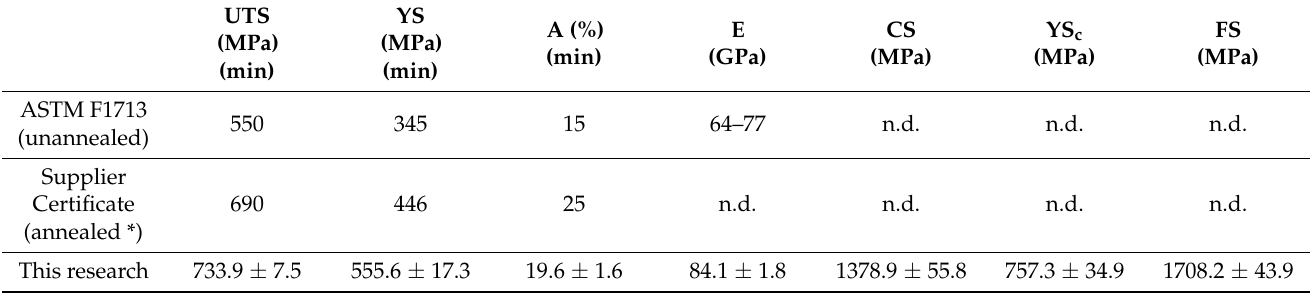
Table 4. Mechanical properties of Ti-13Nb-13Zr alloy.